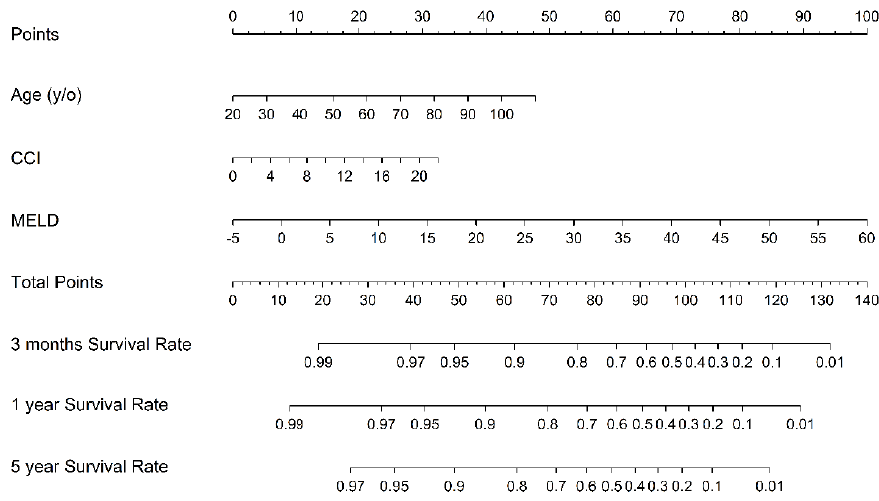
Figure 4. The nomograms of the prognostic indexes based on age, CCI, and the MELD (Model for End-Stage Liver Disease). They give an estimate of the expected survival.